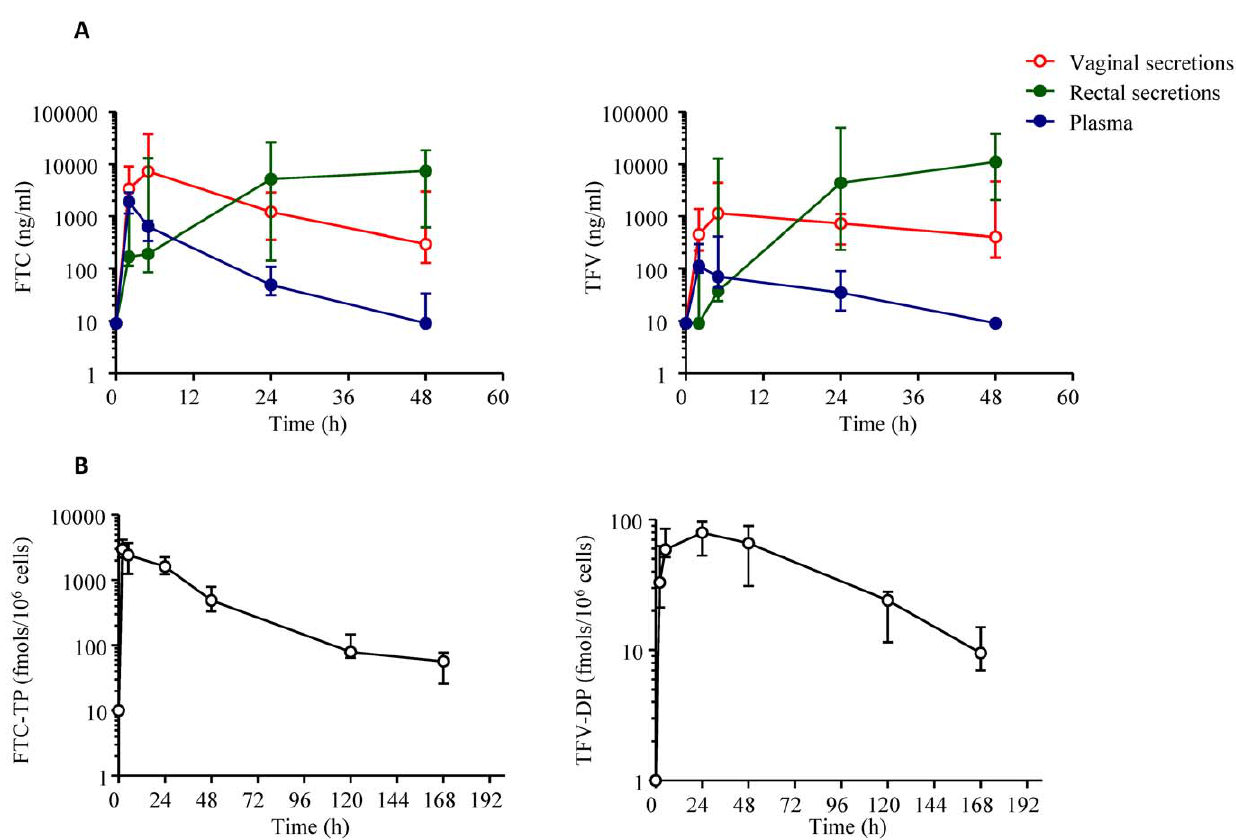
Figure 1. Pharmacokinetic profile of FTC and TDF in pigtail macaques. A: Concentrations of FTC and TFV in plasma, rectal, and vaginal secretions after a single oral dose of FTC and TDF. Secretions were collected in 6 macaques using sponges at the indicated time points. Median concentrations and interquartile ranges (vertical lines) are shown. B: Intracellular FTC-TP and TFV-DP concentrations in pigtail macaque PBMCs. Six pigtail macaques received a single oral dose of FTC and TDF by gavage followed by collection of blood at the indicated time. Median concentrations and interquartile ranges (vertical lines) for FTC-TP (1) and TFV-DP (2) are shown.